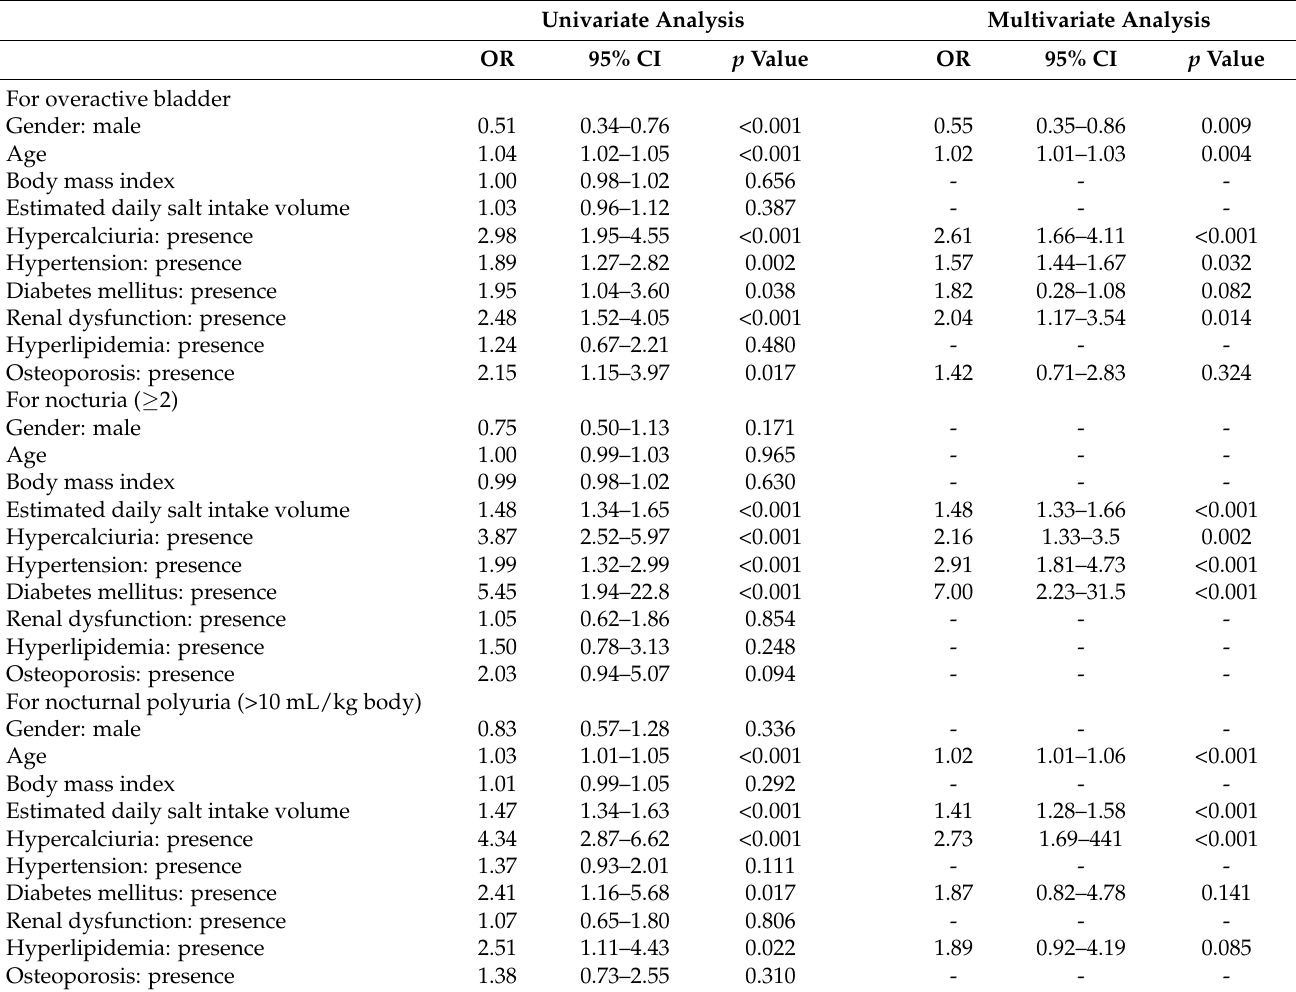
Table 4. Overactive bladder and urinary symptom-related